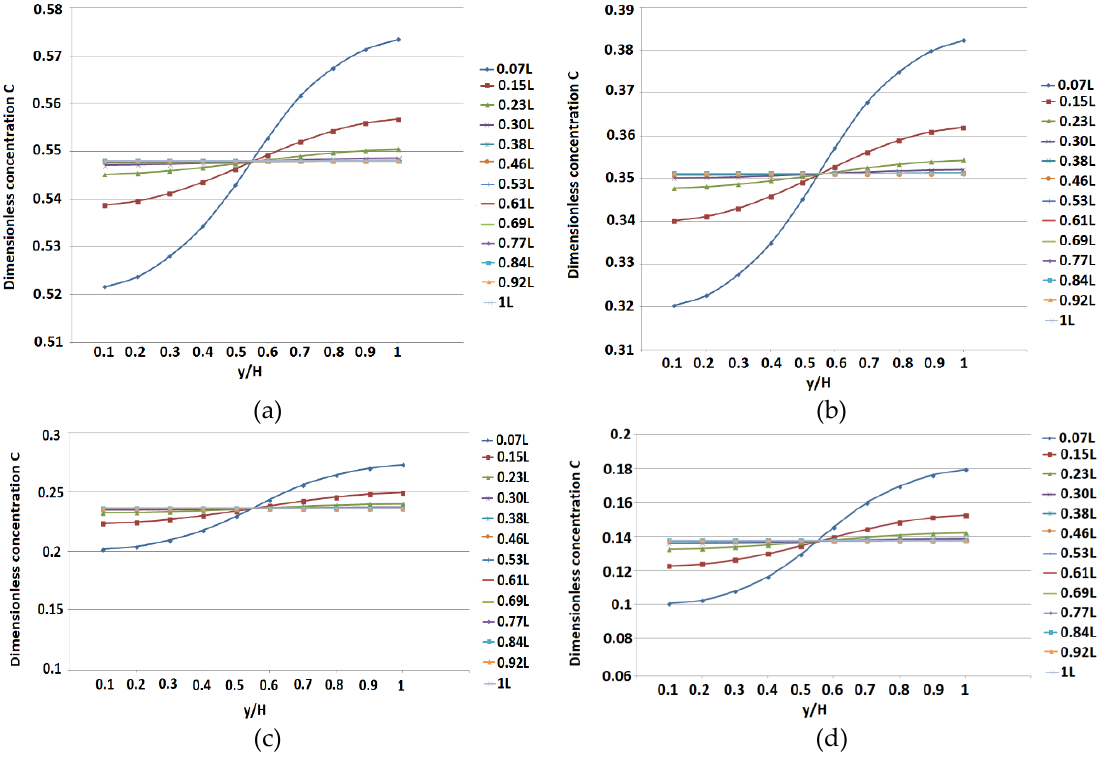
Figure 3. Concentration of substances of the contaminated water for the representative case of θ = 45° for a) Vp/Vc = 0.5, b) Vp/Vc = 5, c) Vp/Vc = 10, d) Vp/Vc = 20.